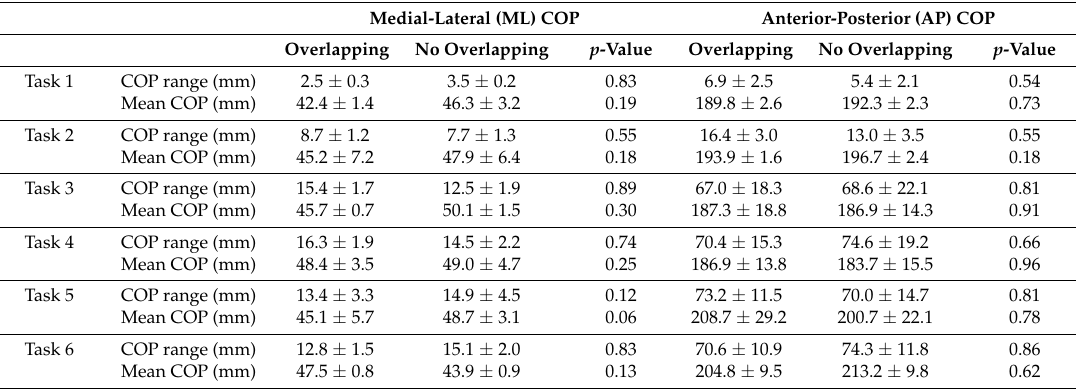
Table 1. Comparisons of COP parameters between the ‘overlapping’ and ‘no overlapping’